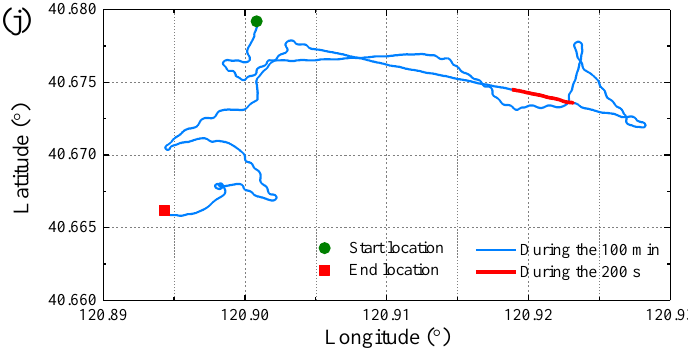
Figure 26. Examples of measured sea trial data: ( a ) model speeds; ( b ) model azimuth; ( c ) pitch motion; ( d ) roll motion; ( e ) vertical speed at COG; ( f ) sectional VBF at #2; ( g ) sectional VBF at #12; ( h ) wave impact pressure at sensor 4; ( i ) bow vertical acceleration; and ( j ) model navigation trace.